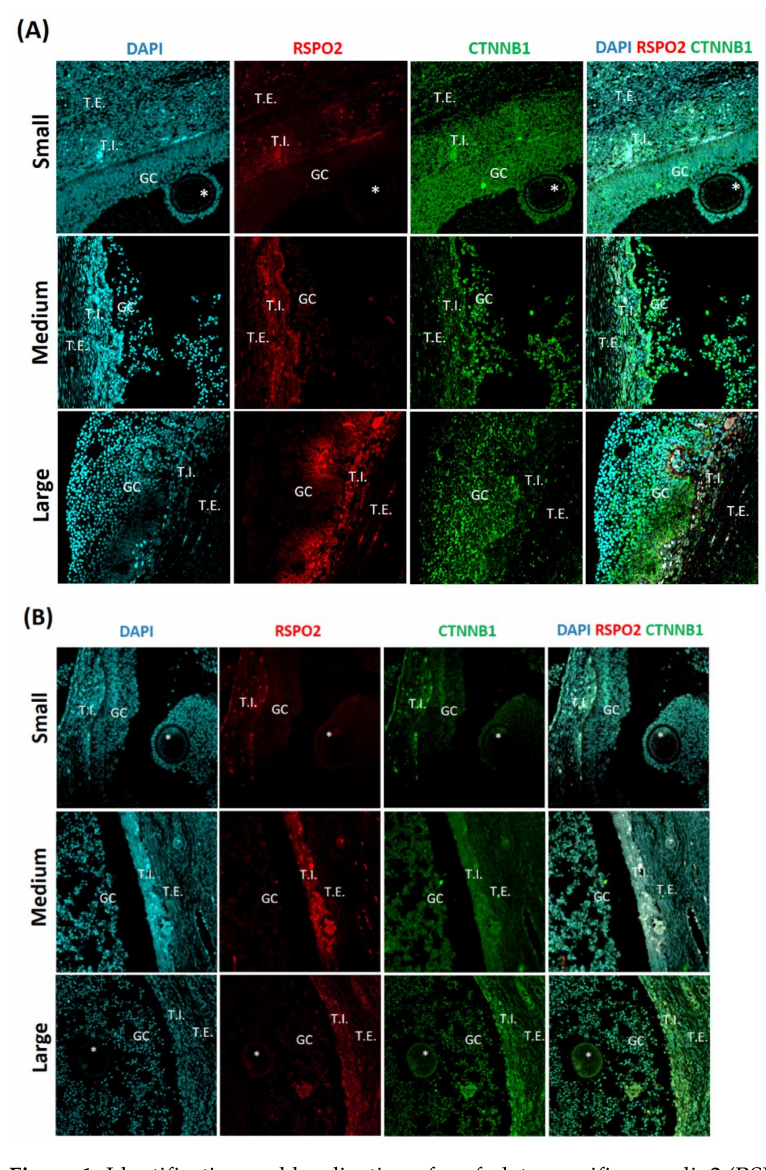
Figure 1. Identification and localization of roof plate-specific spondin2 (RSPO2) related factors in porcine ovarian tissues according to follicle size by immunofluorescence. Each ovary with small (1–2 mm), medium (3–6 mm), and large (7–9 mm) follicles. ( A ) RSPO2 and Catenin beta-1 (CTNNB1), ( B ) G-protein coupled receptor 4 (LGR4) and G-protein coupled receptor 5 (LGR5). theca interna (T.I.), theca externa (T.E.), granulosa cells (GC), and ooplasm